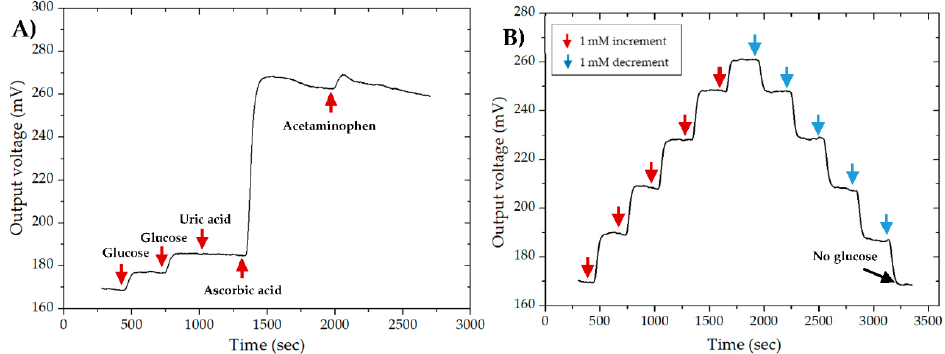
Figure 8. Voltametric responses of the microfluidic, EBFC-based glucose biosensor at a constant current load of 100 µA∙cm −2 for ( A ) interference analysis with the stepwise addition of 0.5 mM glucose, 0.3 mM uric acid, 0.1 mM ascorbic acid, and 0.1 mM acetaminophen, as well as for ( B ) recovery analysis with a stepwise 1 mM increment and 1 mM decrement in glucose